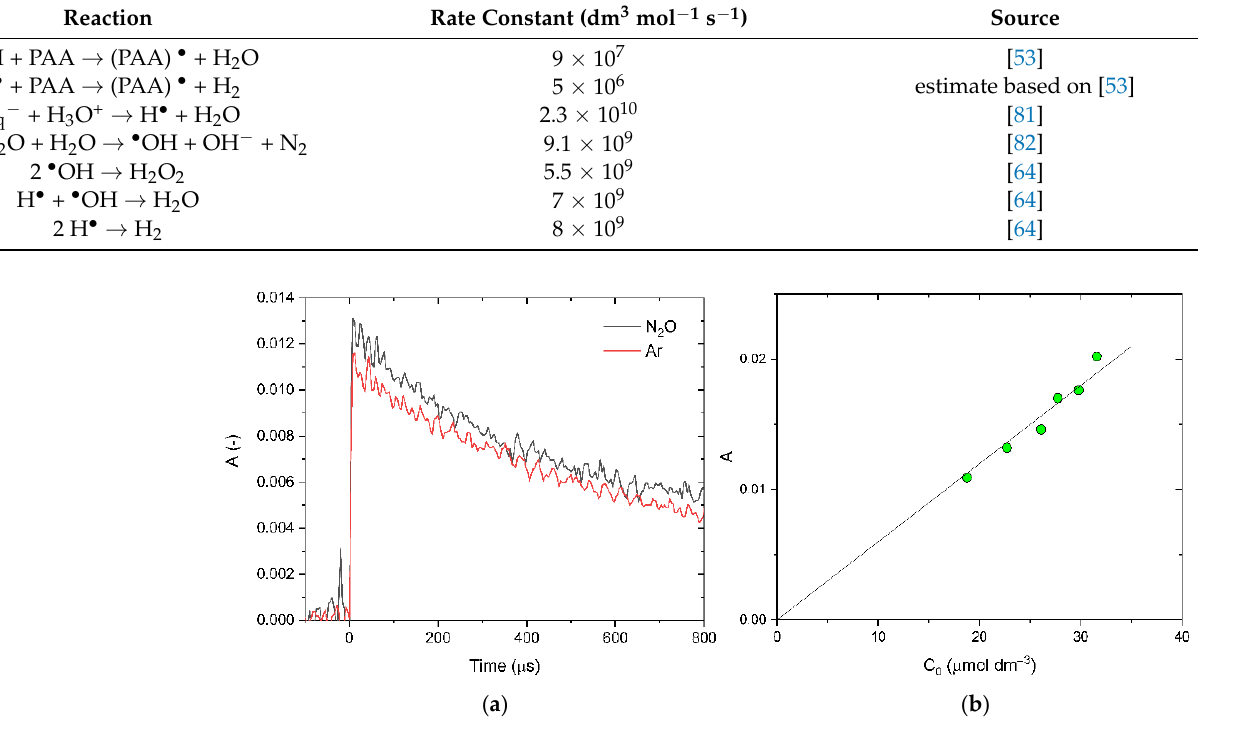
Figure A1. ( a ) Pulse radiolysis of Ar-saturated aqueous solution containing 50 mmol dm − 3 PAA, pH 2. Initial absorbance at λ = 280 nm as a function of initial concentration of PAA radicals, c 0 , calculated by Kinetiscope. ( b ) Comparison of kinetic traces in 10 mmol dm − 3 PAA solutions, pH 2, saturated with argon and nitrous oxide, dose per pulse 67